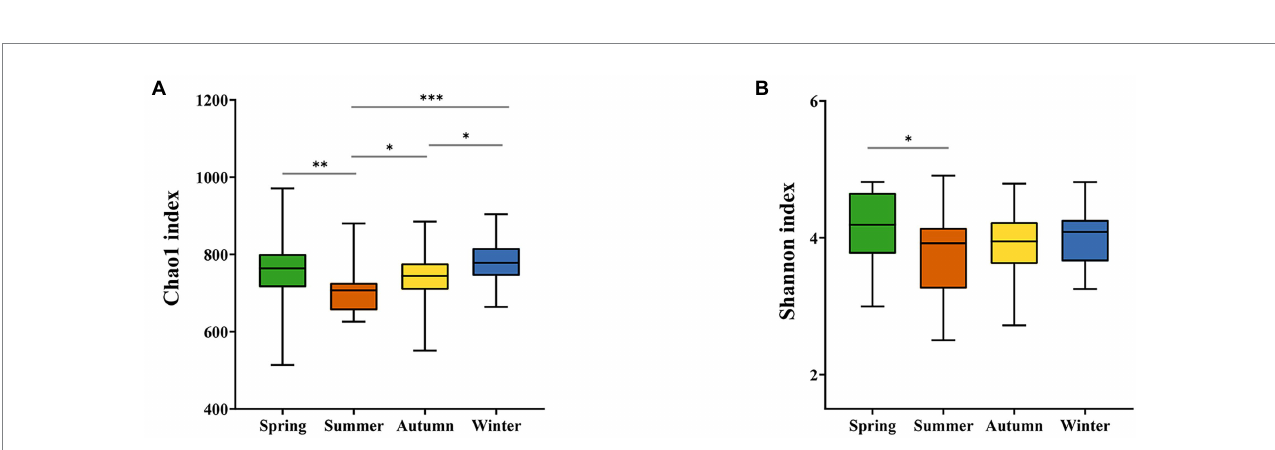
FIGURE 2 Alpha-diversity of gut microbiota. The Chao1 indexes fluctuate significantly between seasons (A) , while the Shannon indexes vary only in spring and summer and are stable for the rest (B) . * p < 0.05, ** p < 0.01, *** p < 0.001 (Kruskal-Wallis